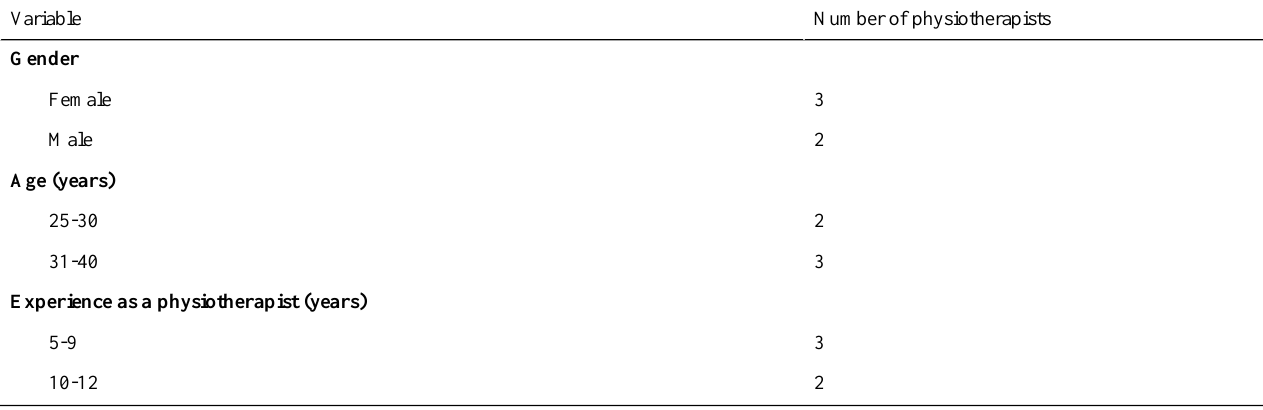
Table 2. Characteristics of the physiotherapists involved in the development phase (phase 1) of the mobile app